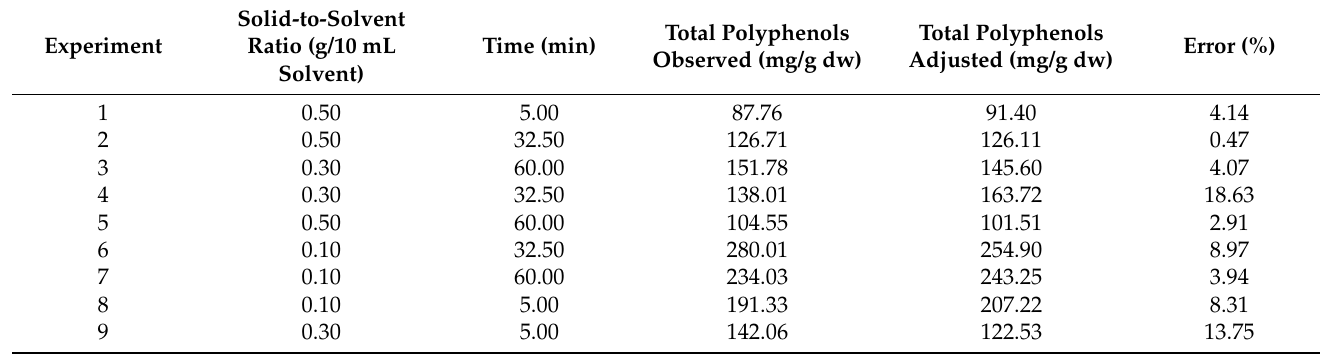
Table 3. Experimental conditions and the resulting two ‐ factorial design used to optimize: solid ‐ to ‐ solvent ratio and extraction time parameters.